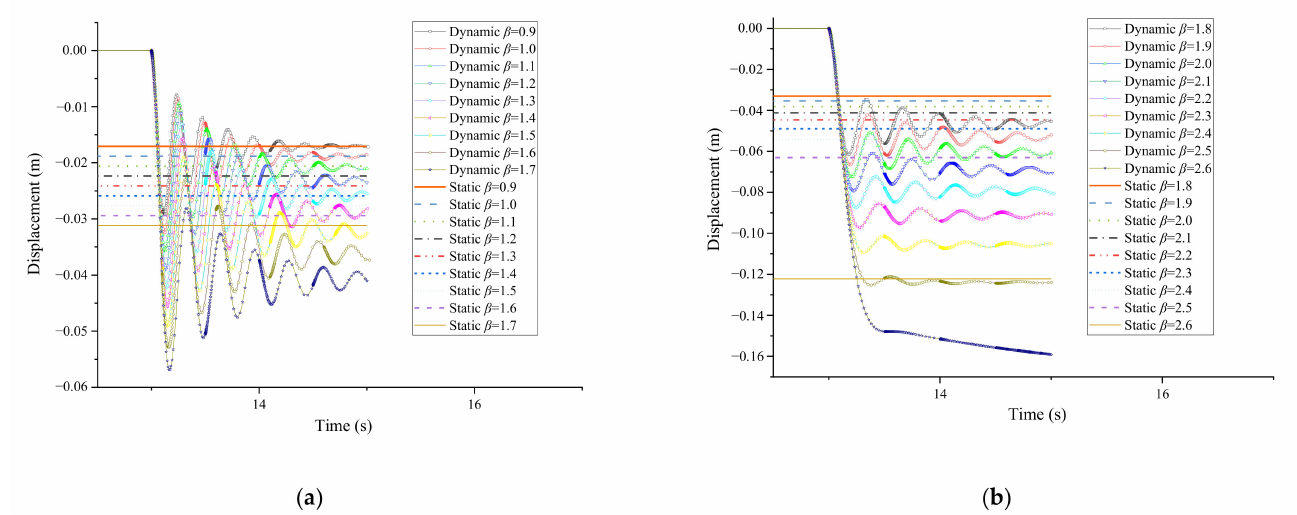
Figure 21. Displacements of the bottom of the interior column in dynamic and static analyses under gradually increasing loads ( β = 0.9–2.6): ( a ) when β = 0.9–1.7; ( b ) when β =